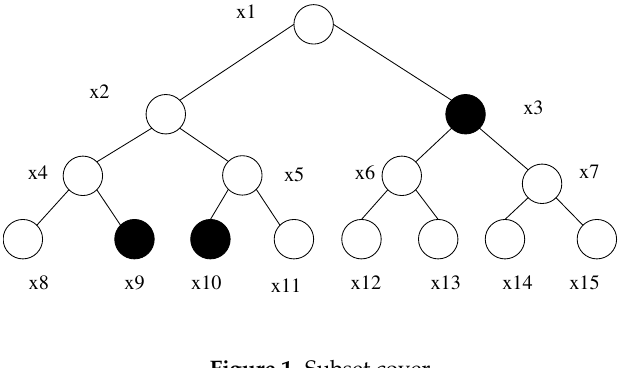
Figure 1. Subset